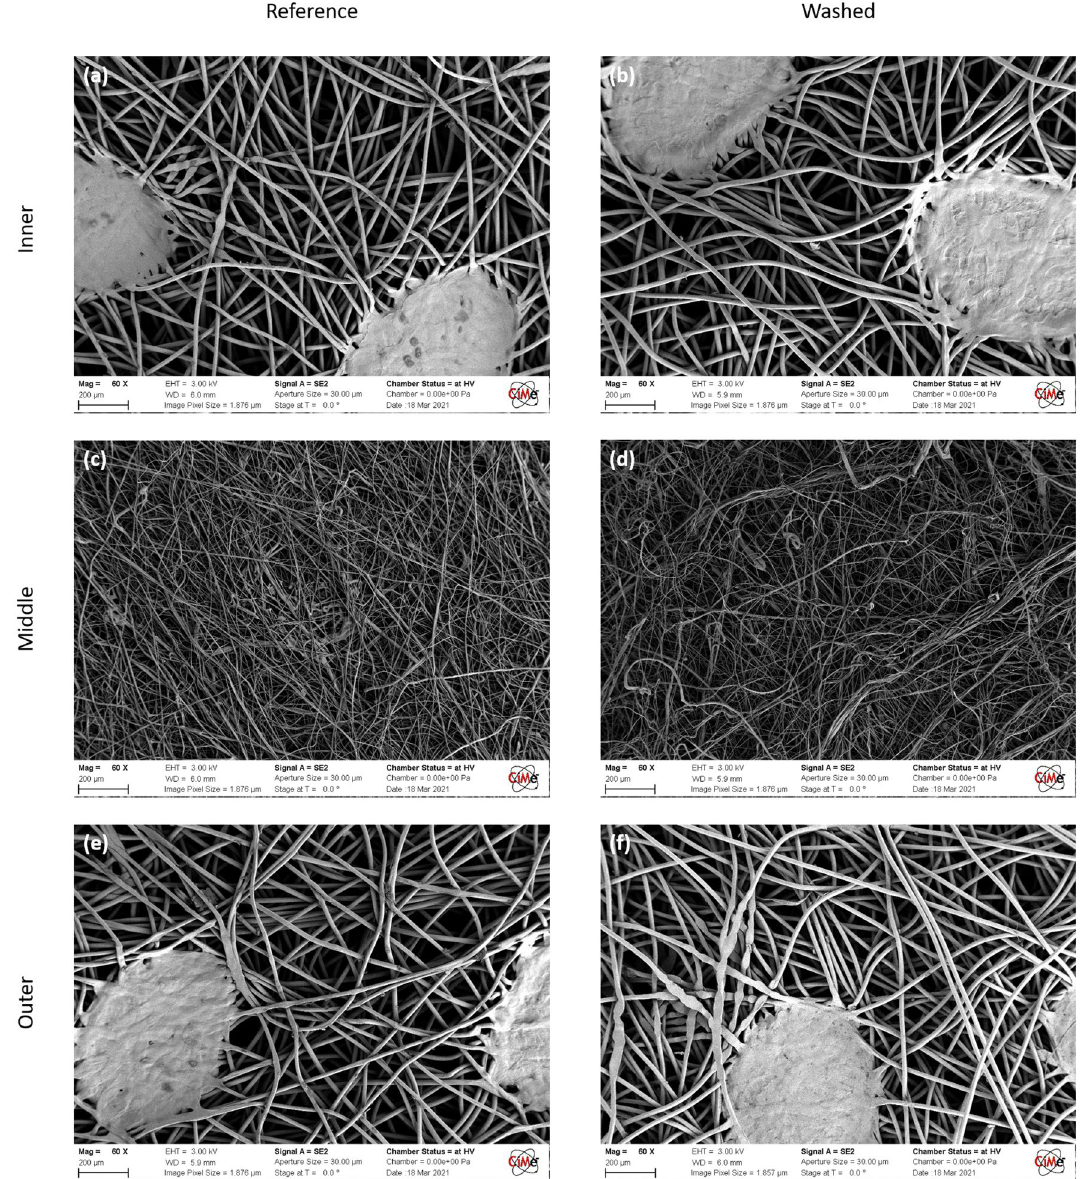
Figure 3. SEM micrographs of each layer from a reference and washed mask: ( a , b ) inner layer made of spunbond PP fibers with diameters of 15–20 microns, ( c , d ) middle layer made of melblown fibers with diameters of 1–3 microns, ( e , f ) outer layer made of spunbond PP fibers as the inner